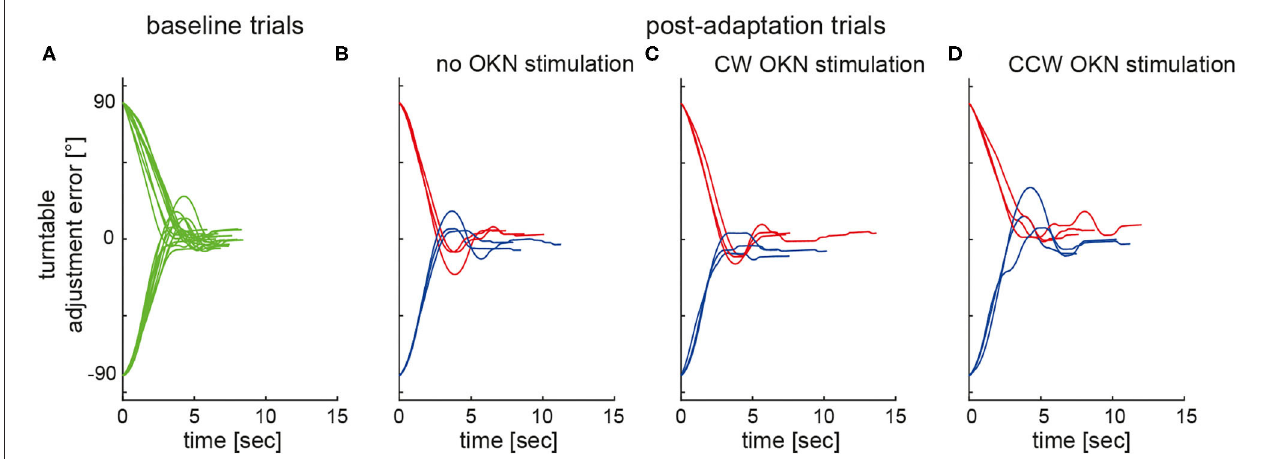
FIGURE 2 | Individual turntable adjustments relative to earth-vertical are plotted against time in a single subject (#10). Whereas, baseline trials (A) are shown in green, post-adaptation (test) trials (adaptation period not shown) are plotted in blue (adaptation position: 90 ◦ LED) and in red (adaptation position: 90 ◦ RED), respectively, for the different test conditions (B–D)